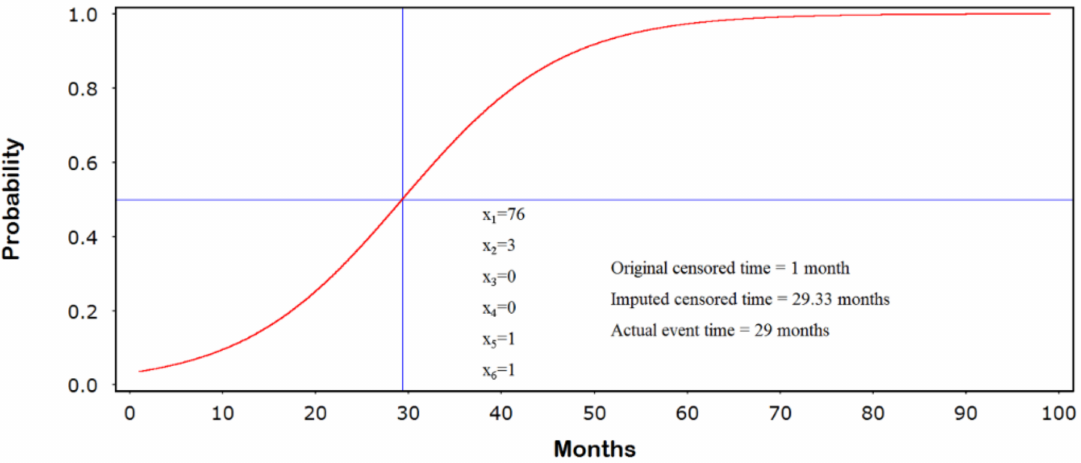
Figure 4. Jump-point